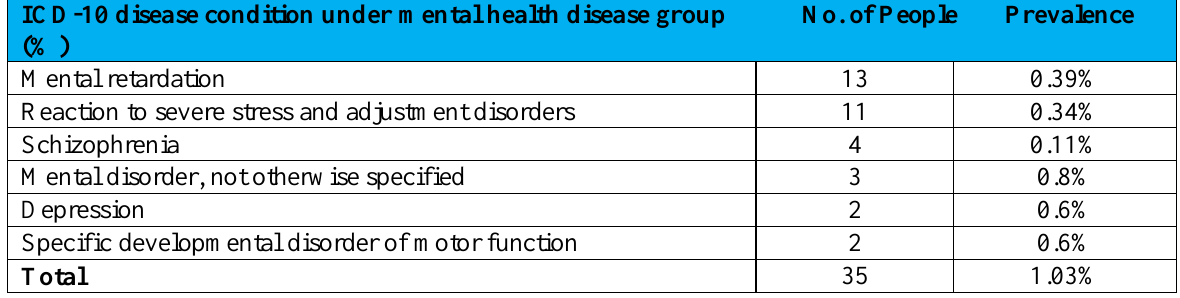
Table 2: Top disease conditions (ICD-10) under mental health disease group among Congolese refugees (n=3,577) screened in Burundi, Rwanda, Uganda, and Kenya, 2010 – 2012 ICD-10 disease condition under mental health disease group No. of People Prevalence (%) Mental